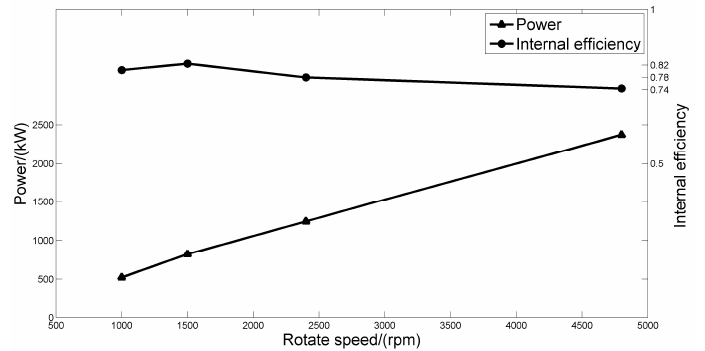
Figure 12. Internal efficiency and power for different rotate speed ( P i = 1.3 MPa, T i = 192 °C, P o = 0.19 Mpa).